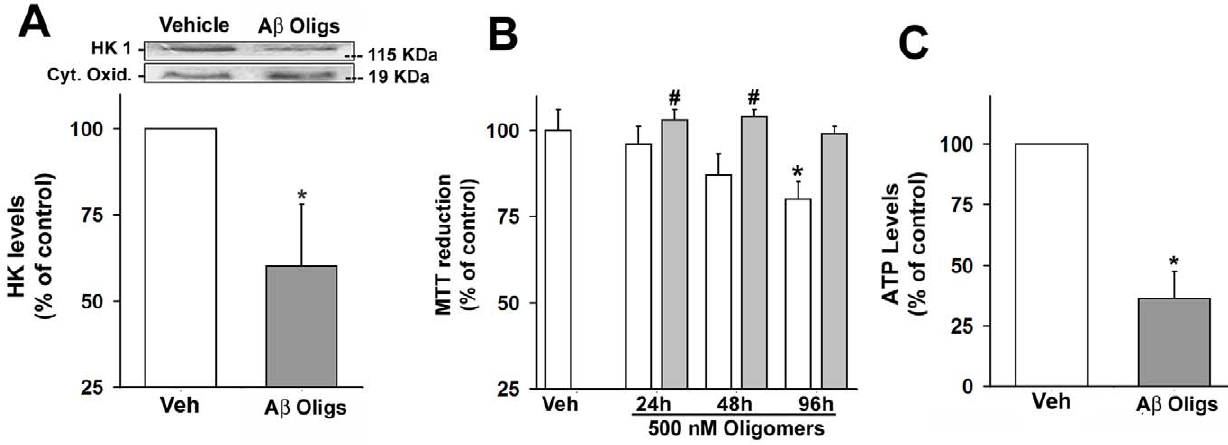
Figure 2. Effects of A b oligomers on neuronal m-HKI and ATP levels. Panel A: A b oligomers triggers the release of m-HKI from mitochondria. Western immunoblot analysis of HKI levels in mitochondrial fractions from cultured cortical neurons exposed to 500 nM A b oligomers (ADDLs) (D) for 24 hours. Cytochrome c oxidase was used as a loading control. Bars correspond to means 6 SE from at least three independent experiments carried out in duplicate. Panel B: Time-dependent toxicity of ADDLs (white bars) or A b monomers (gray bars) to mature hippocampal neurons measured using the MTT reduction assay. Values represent the means 6 SD of the relative absorbance measured using 6 wells for each experimental condition for three independent experiments. (*) indicates a statistically significant (p , 0.005) difference relative to control cultures. Panel C: A b oligomers decrease ATP levels in mature cortical neurons. Cultures were exposed to vehicle or 500 nM ADDLs for 12 hours. Values represent means 6 SD of the relative levels measured in five independent experiments.